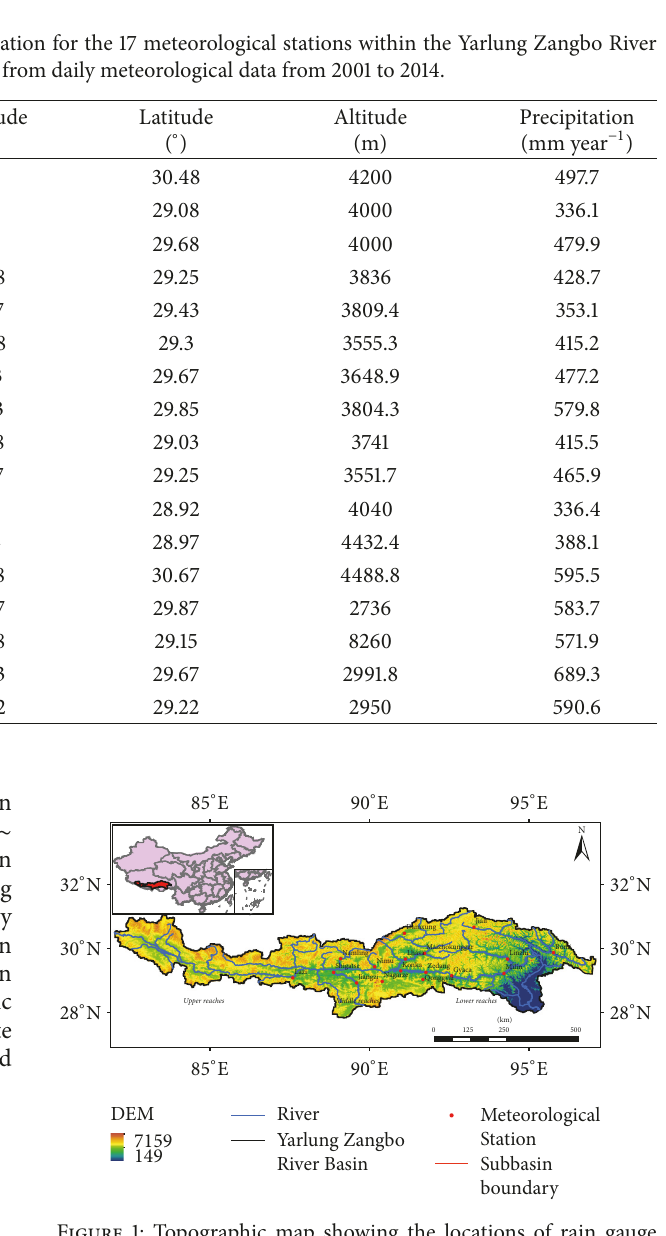
Figure 1: Topographic map showing the locations of rain gauge stations in the Yarlung Zangbo River